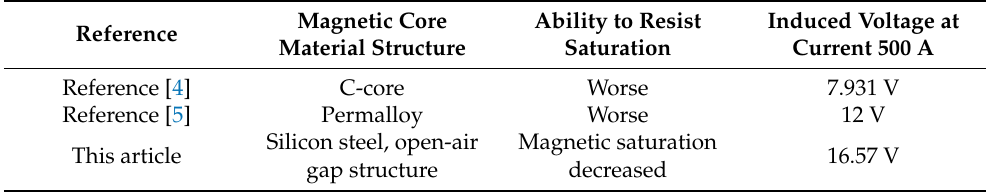
Table 6. Contrast table of CT-induced power extraction